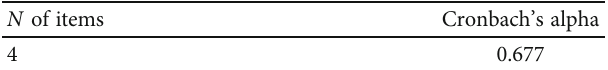
Table 10: Cronbach ’ s alpha for job satisfaction.